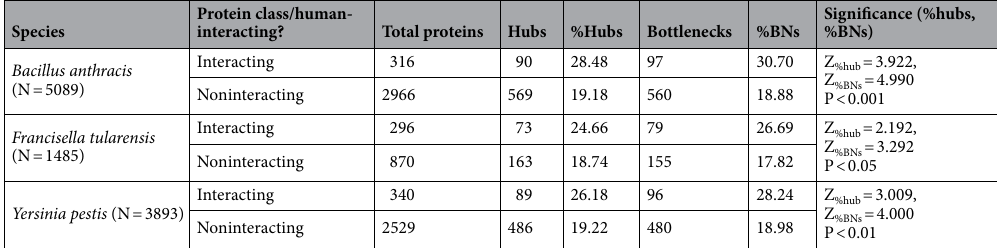
Table 3. Proportion of hubs and bottlenecks in bacterial pathogens’ PPI network in human-interacting and non-interacting proteins.